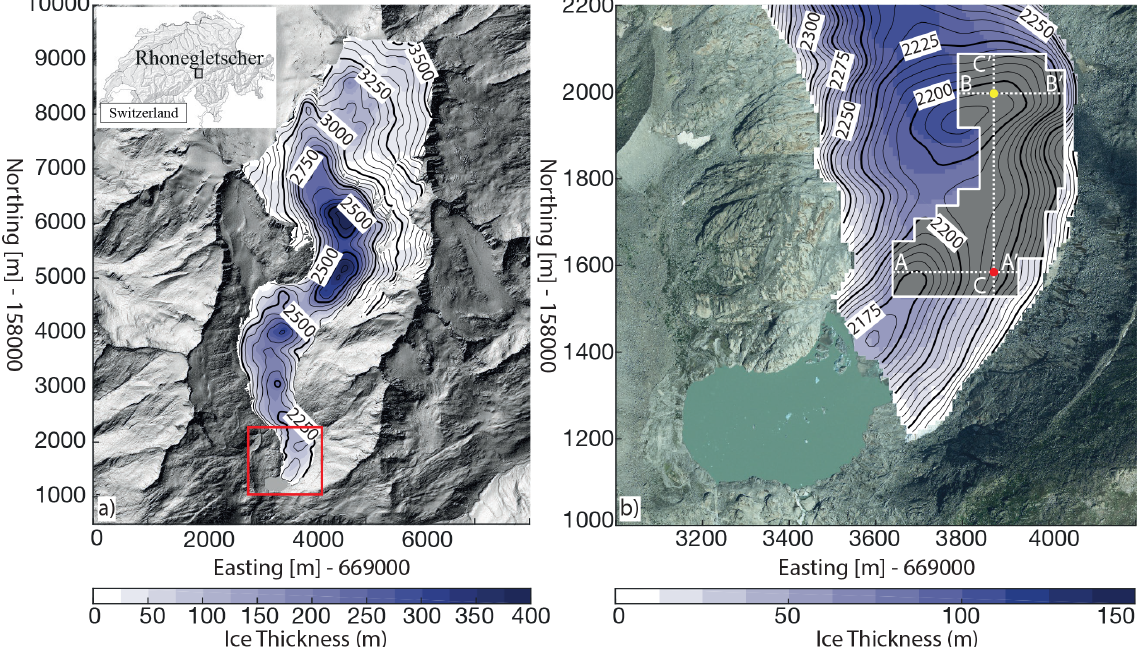
Figure 1. (a) Rhonegletscher ice thickness in 2019 (colours) and bedrock elevation (contours) estimated using the GlaTe model from 59 interpolated radar profiles acquired between 2003 and 2008 as described by Grab et al. (2021). The red box represents the zoomed area for panel (b) . (b) Lower ablation zone of Rhonegletscher showing ice thickness (colour) and bedrock elevation (contours). The grey polygon represents the 3D GPR survey sites; three GPR profiles, i.e. A–A’, B–B’, and C–C’, are shown in Fig. 2; and the crossing points of the GPR profiles are represented by yellow and red dots. Co-ordinates for all plots are local Swiss co-ordinates LV03. Orthophoto was provided by Swiss Federal Office of The topology is reproduced by permission of swisstopo (JA100120), © 2020 swisstopo